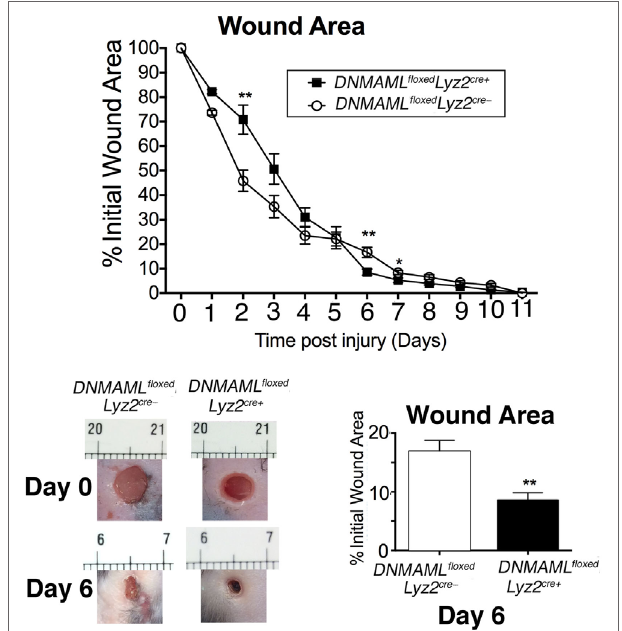
FigUre 7 | high-fat diet (hFD) mice deficient in notch signaling (hFD DNMAML floxed Lyz2 Cre + ) demonstrate improved late healing compared to hFD controls . DNMAML floxed Lyz2 Cre + and littermate control mice were fed a HFD (60% fat) for 12–14 weeks. Two wounds per mouse were created using 4 mm punch biopsies on the backs of HFD DNMAML floxed Lyz2 Cre + and HFD littermate control mice. Change in wound area was recorded daily using ImageJ Software (NIH) until complete healing was observed. Representative images of wounds from days 0 and 6 are shown ( n = 20 wounds in 10 mice/ group) (* P < 0.05; ** P < 0.01). Statistical analysis was performed using two-tailed Student’s t -test. All data are expressed as mean ±